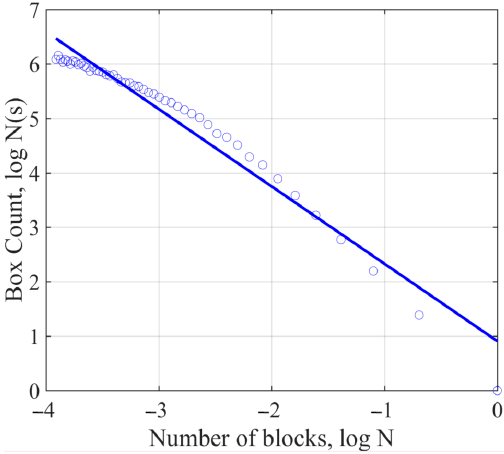
Figure 7. Logarithmic relationship between box count and each box size.